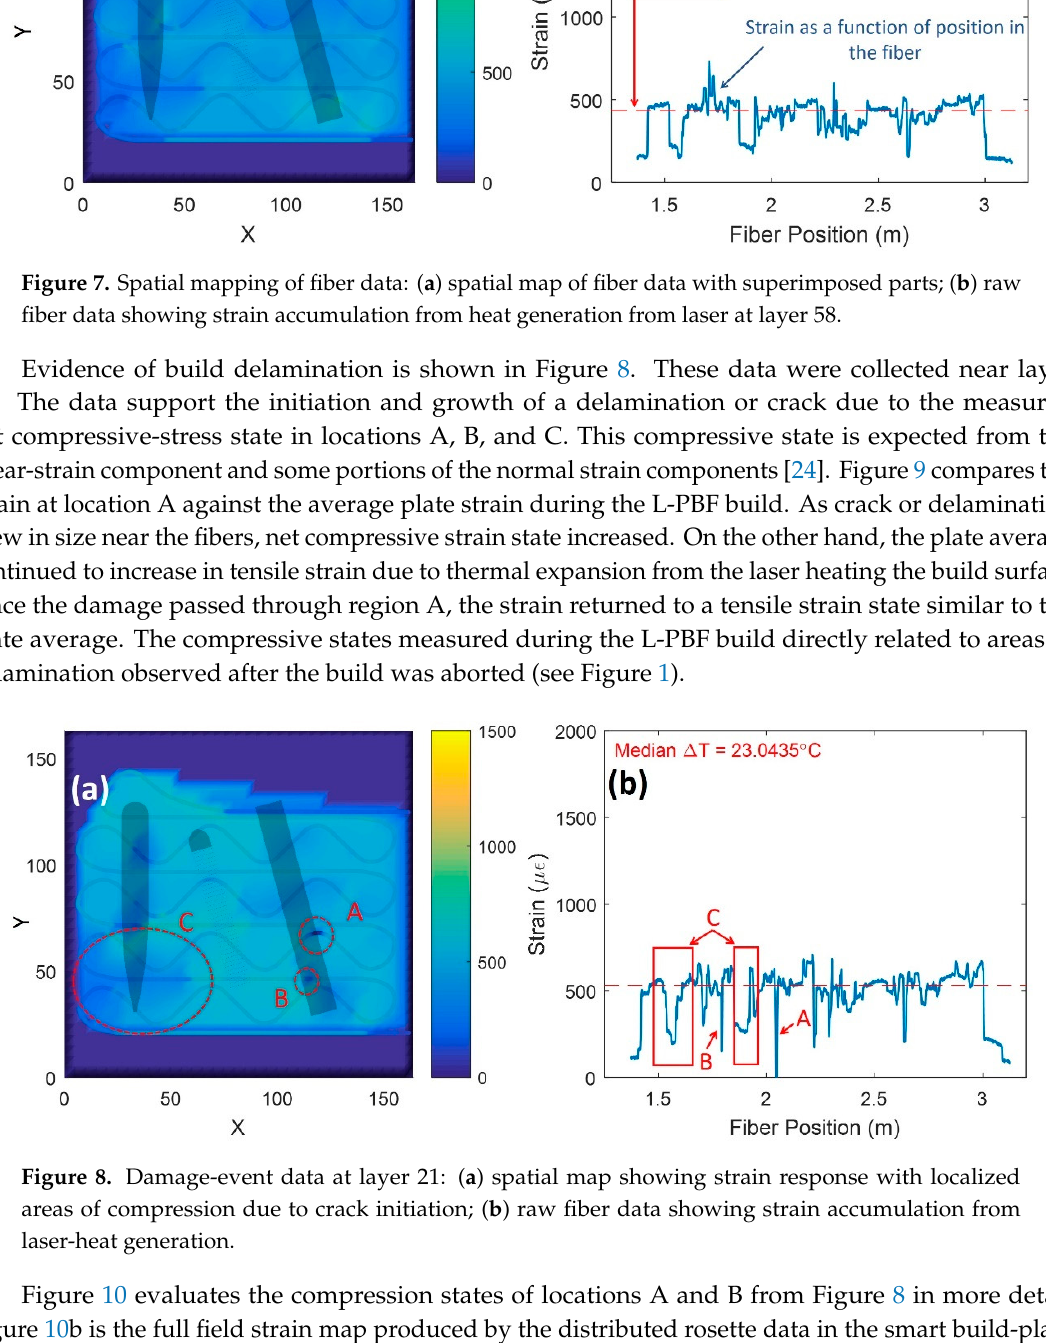
Figure 8. Damage-event data at layer 21: ( a ) spatial map showing strain response with localized areas of compression due to crack initiation; ( b ) raw fiber data showing strain accumulation from laser-heat generation.